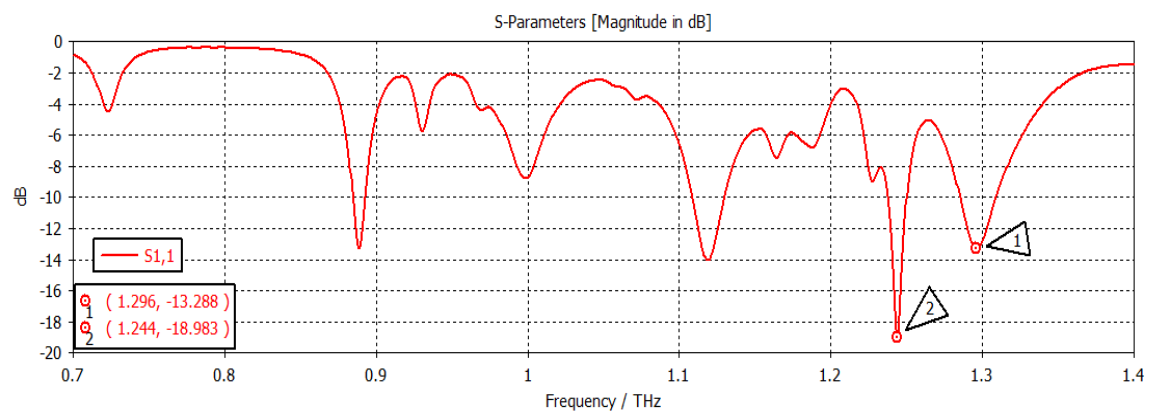
Figure 9. Chemical potential = 0.6. Table 2. Graphene parameters.